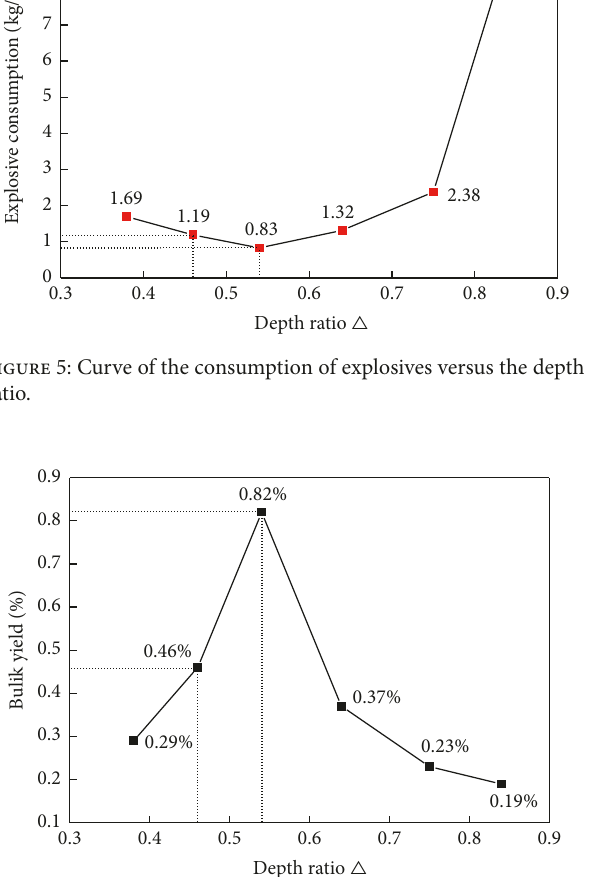
Figure 6: Curve of the bulk yield versus the depth of the